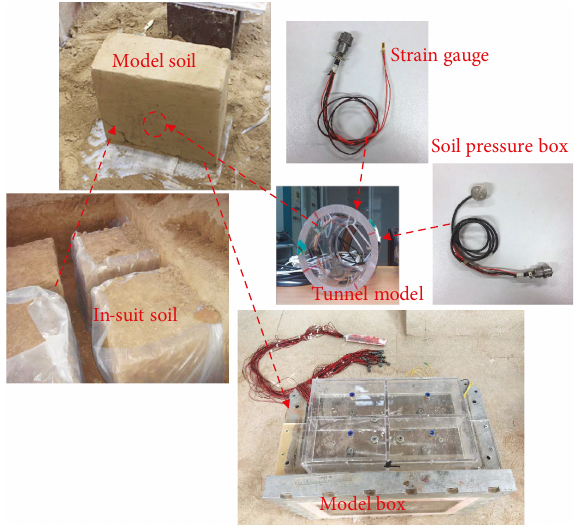
Figure 3: Results for half-range soaking.